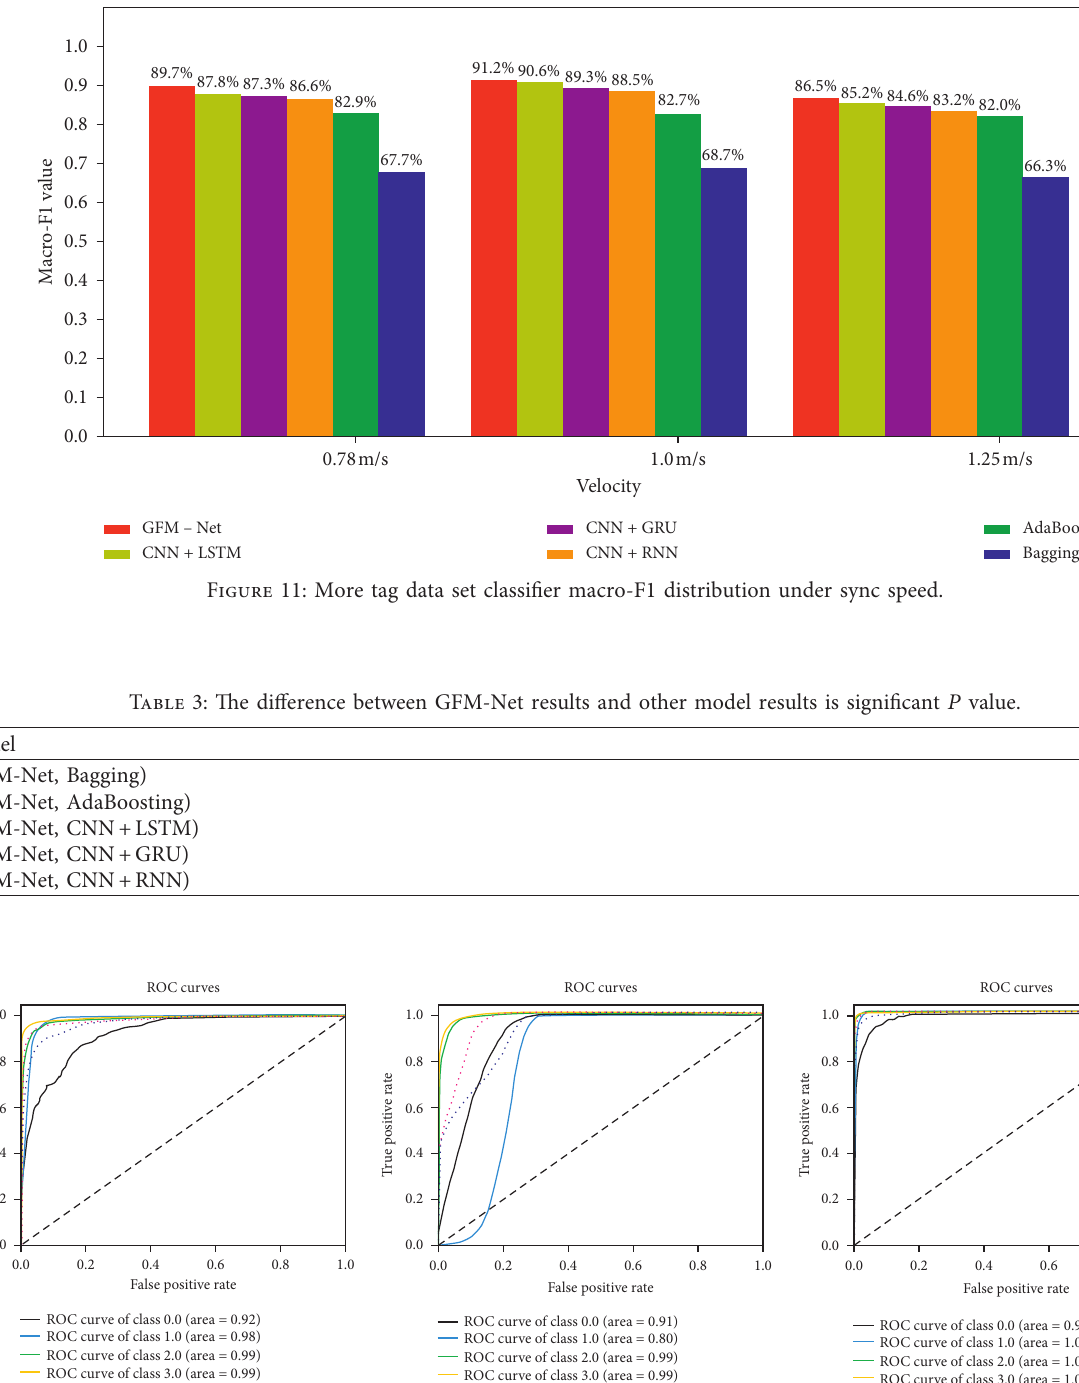
ROC curve of class 0.0 (area = 0.98) ROC curve of class 1.0 (area = 1.00) ROC curve of class 2.0 (area = 1.00) ROC curve of class 3.0 (area = 1.00) Micro-average ROC curve (area = 1.00) Macro-average ROC curve (area =